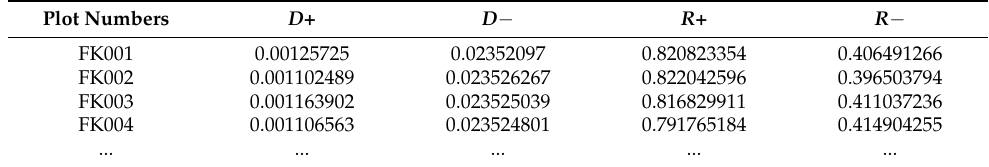
Table 3. Positive and negative ideal solutions for Euclidean distance and Grey relational degree.